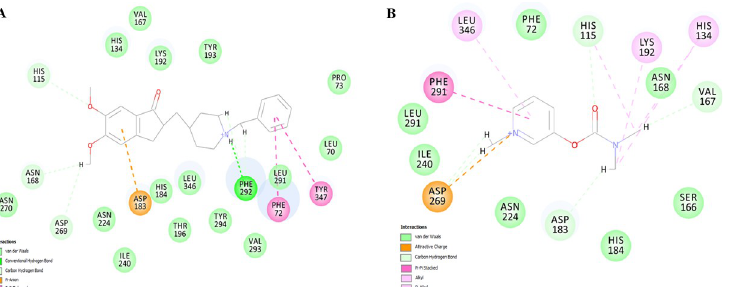
Fig 3. Docking of drug compounds in HuPON2. A. In silico docking of the 3D structure of HuPON2 with DHC and B. In silico docking of the 3D structure of HuPON2 with PB. Various interacting residues are shown and the type of their interaction is color-coded. Discovery studio software was used for the visualization of the results and the creation of images.